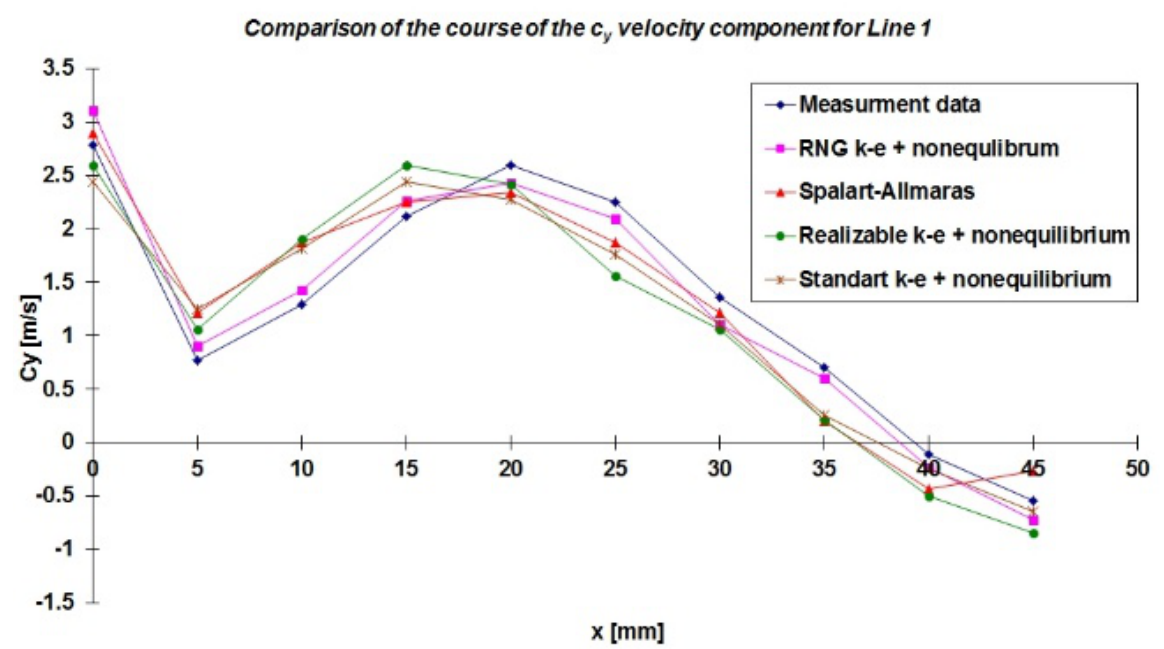
Figure 13. Comparison of the course of the cx, cy velocity components for Line 1.